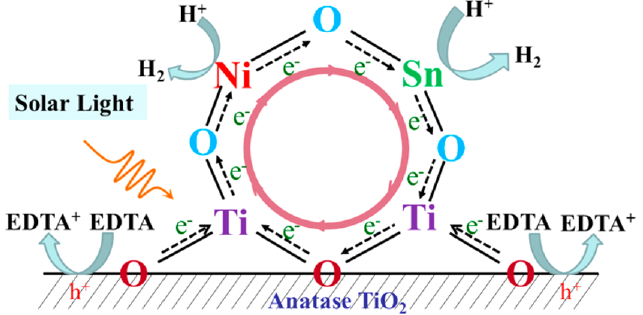
Figure 5. The scheme of the ring mechanism for electron delocalization. Copyrights 2015 ACS [71].